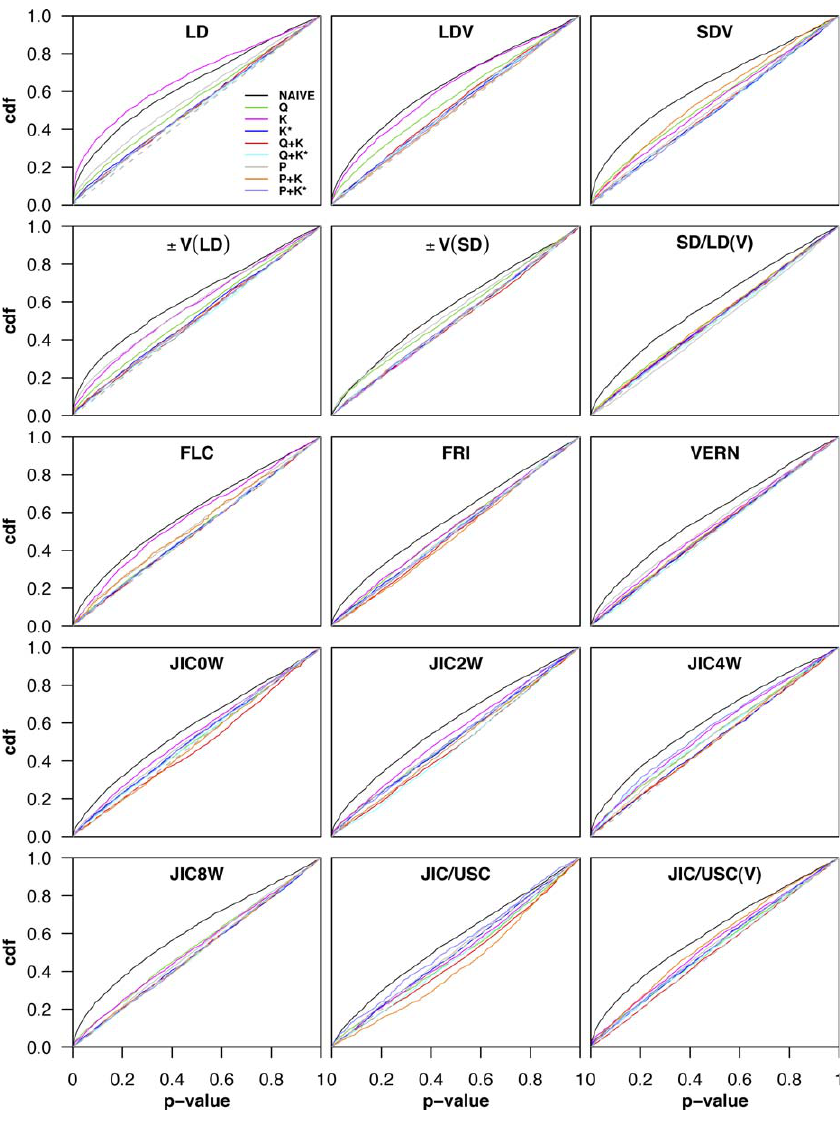
Figure 2. The Cumulative Distribution of p -Values in Genome-Wide Scans for All Phenotypes The different curves correspond to different approaches for correcting for population structure (described in Table 2). Without correction for population structure, all distributions are strongly skewed towards significance. The results shown here are for associations between phenotype and individual SNPs: results for haplotypes were very similar (see Figure S2). cdf, cumulative distribution